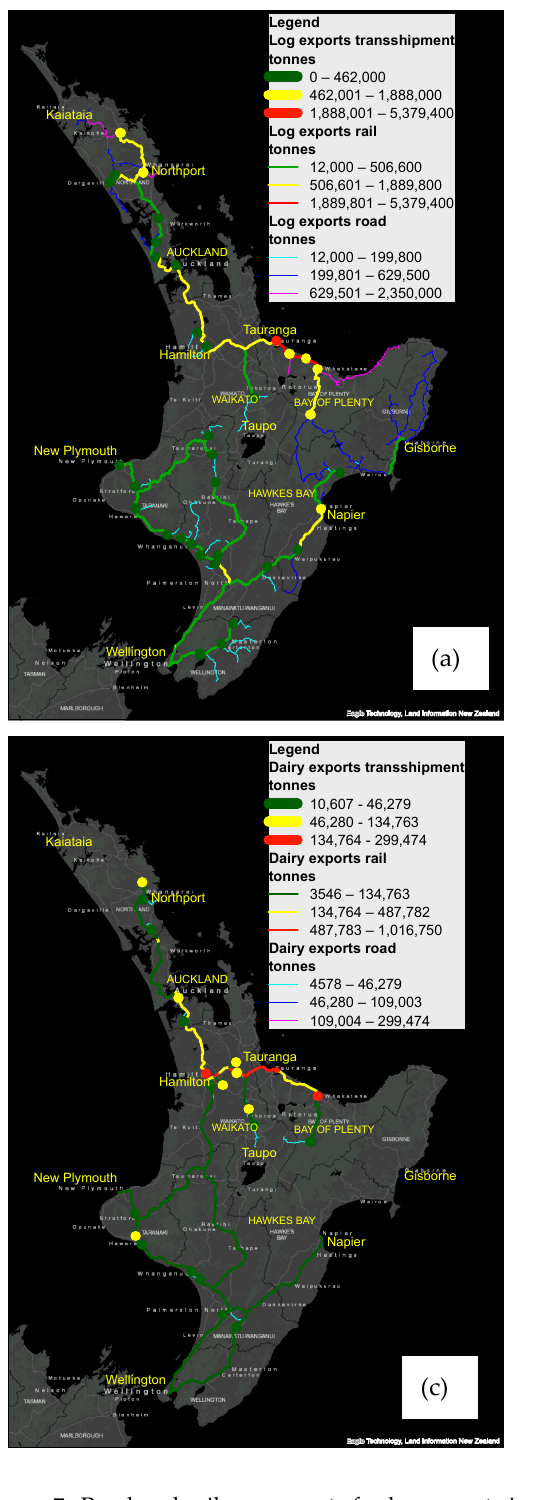
Figure 7. Road and rail movements for log exports in ( a ) BAU-NC-E and ( b ) FS-NC-E scenarios, and dairy exports in ( c ) BAU-NC-E and ( d ) FS-NC-E scenarios.